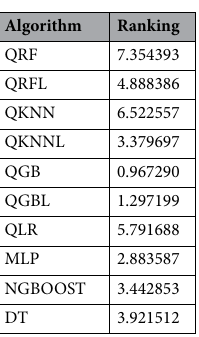
Table 2. Average rankings of the algorithms